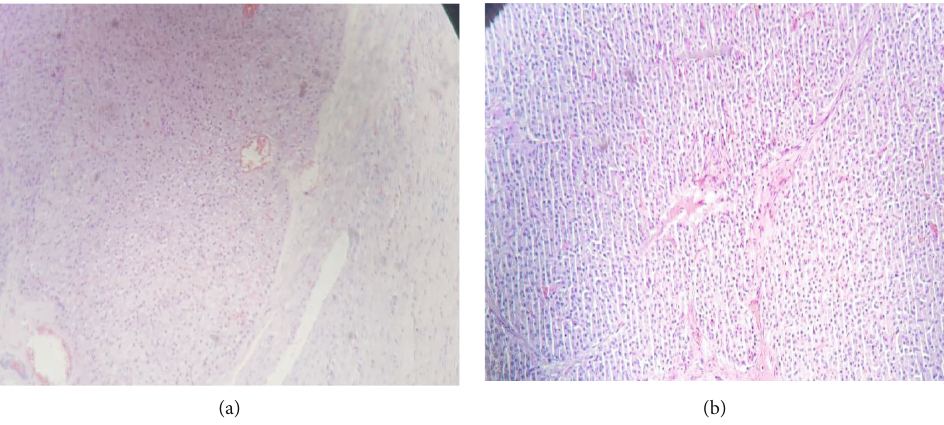
Figure 3: (a, b) Microscopic view of ovarian tissue after H and E